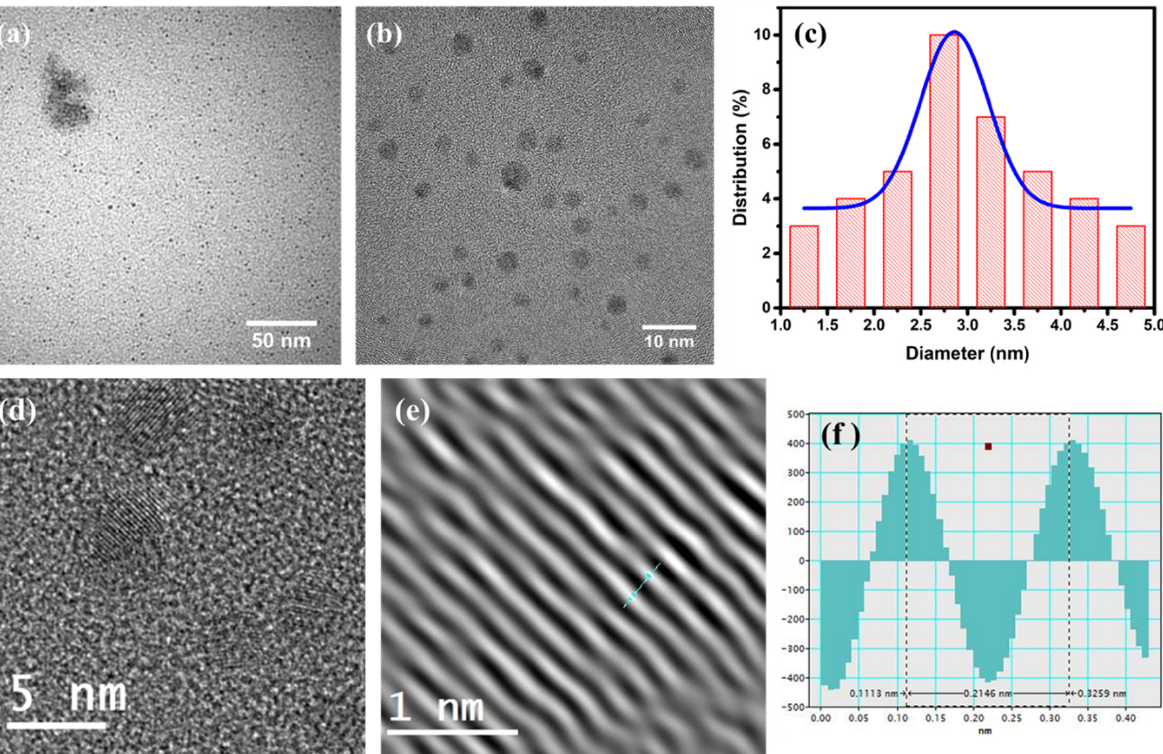
Figure 5. Transmission electron microscopy images of GQDs-250-12 ( a ) at low magnification, ( b ) at high magnification and ( c ) particle size distribution of GQDs. ( d ) HRTEM image of GQDs, ( e ) magnified image of lattice fringes and ( f ) line profile showing the distance between adjacent lattice fringes.